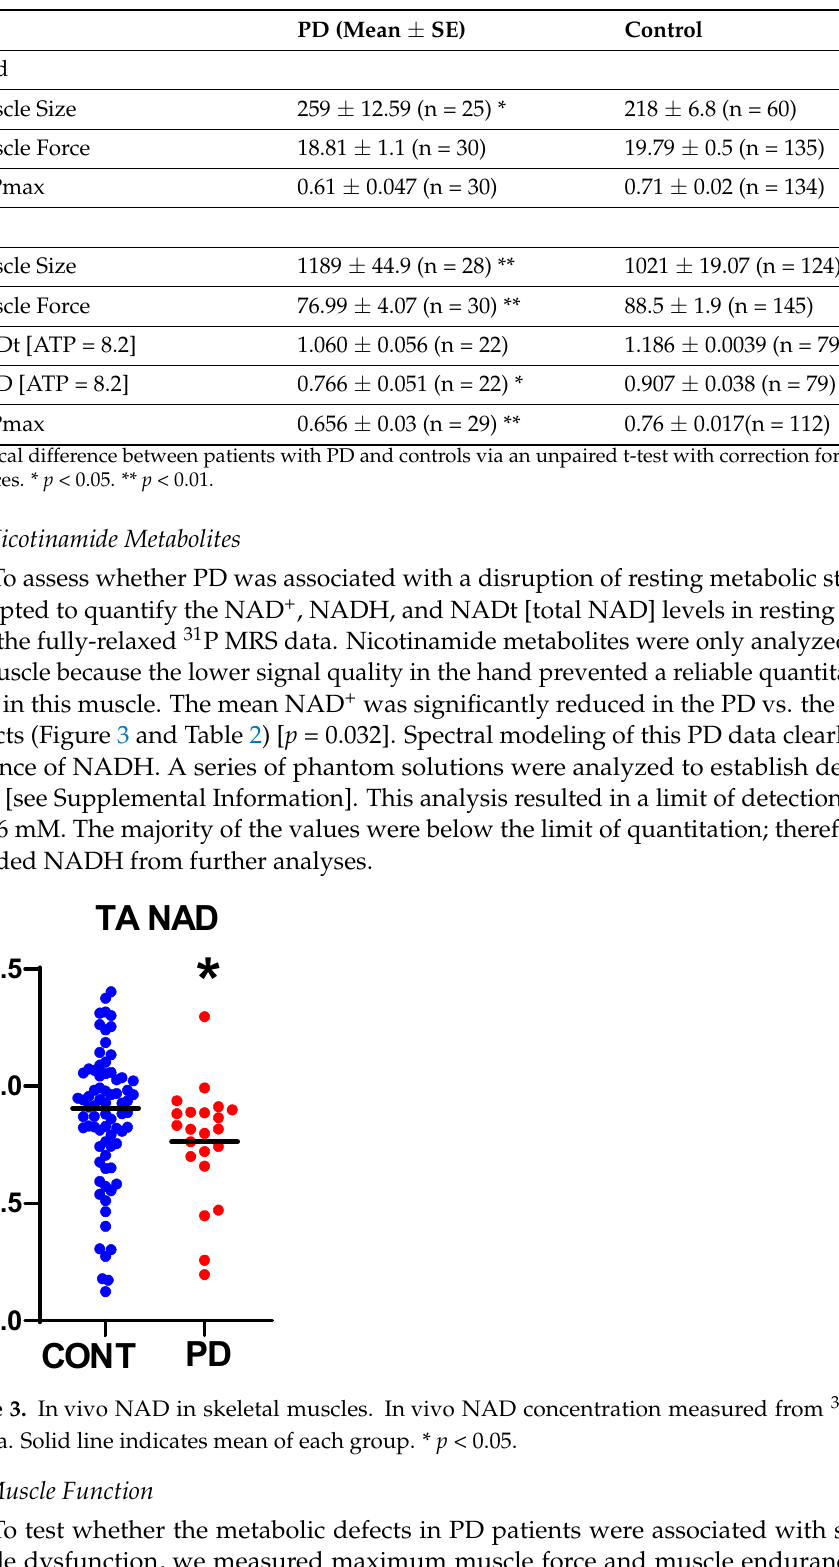
Table 2. Muscle size, force production and bioenergetic properties for the tibialis anterior (TA) from control and PD subjects.